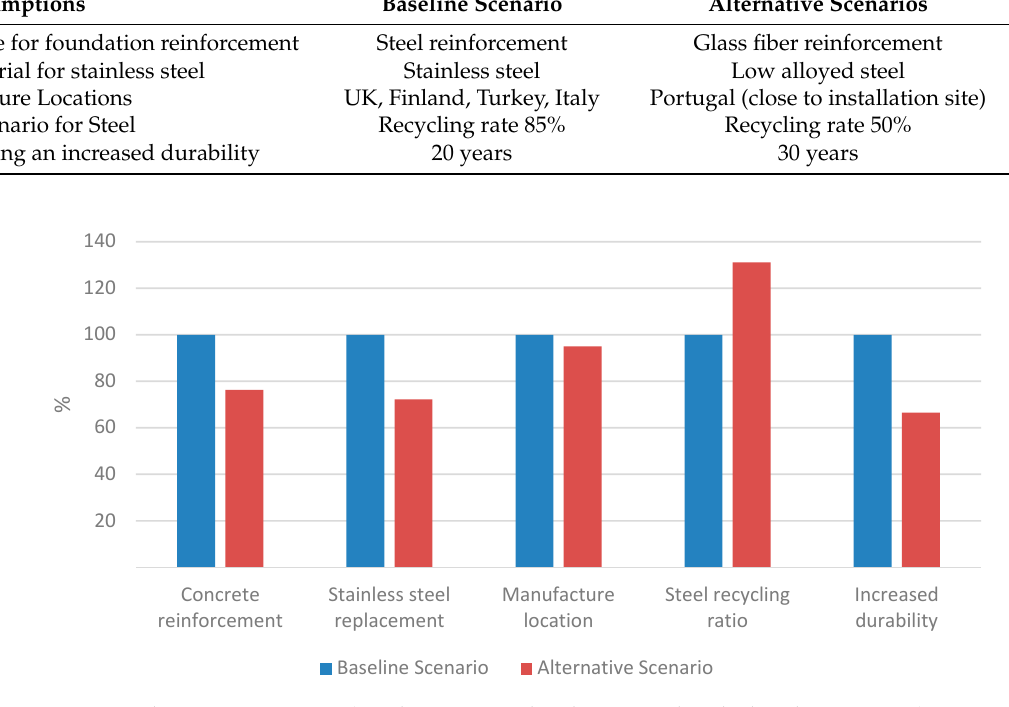
Table 6. Parameters for scenario analysis.